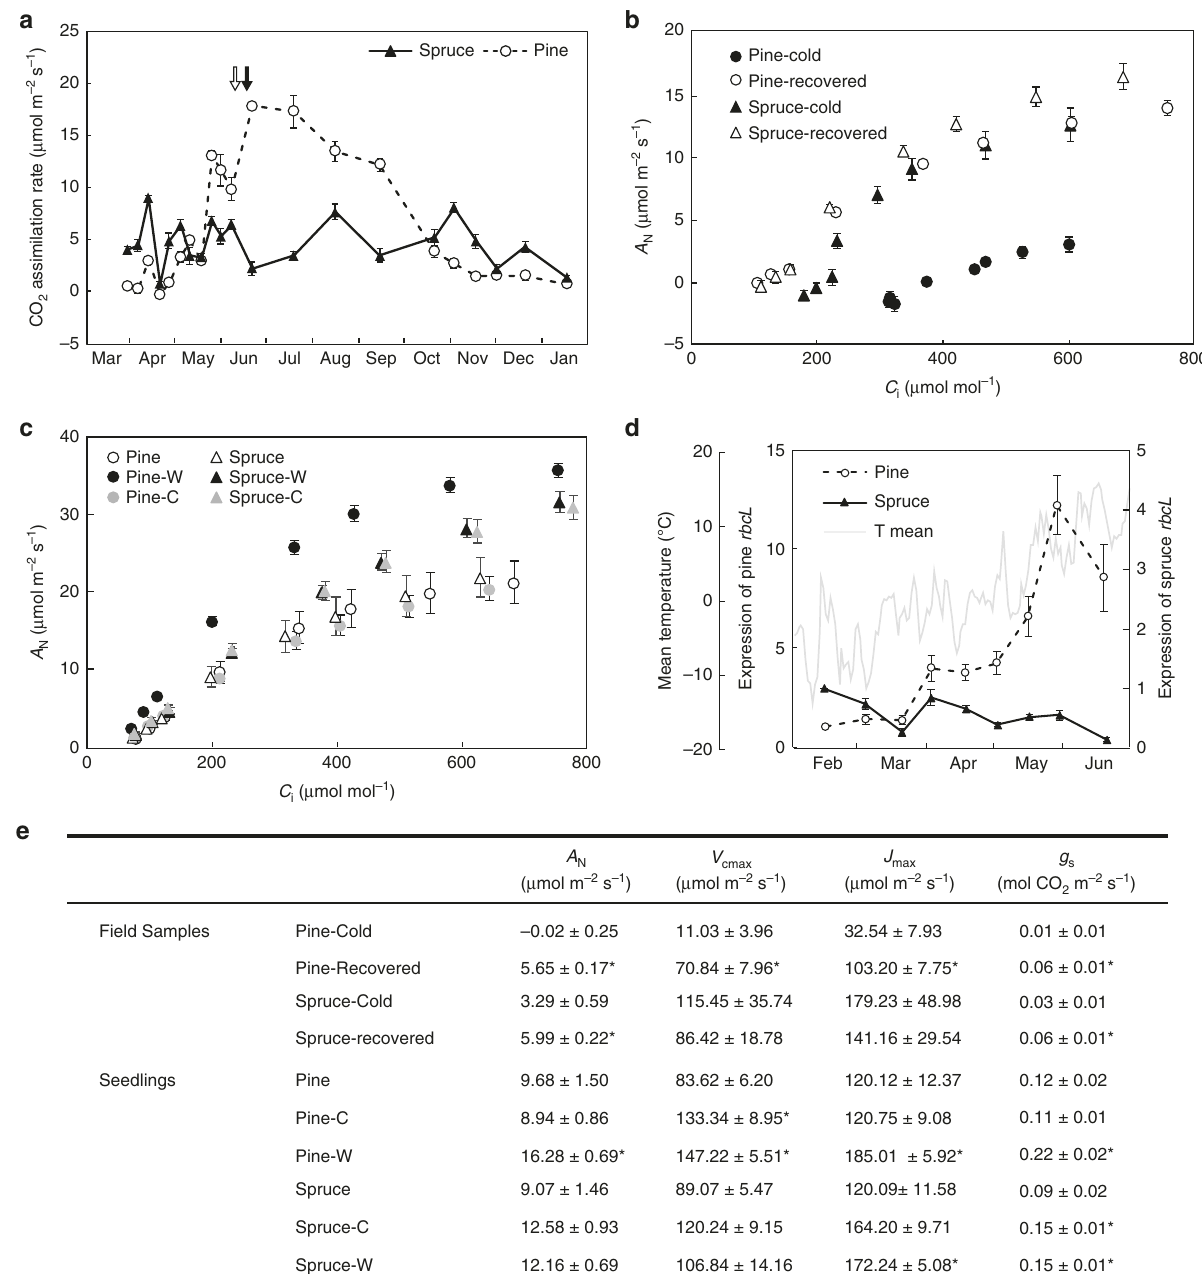
Fig. 3 The capacity for CO 2 assimilation is downregulated in winter and reactivated with warm temperature in Scots pine. a Seasonal photosynthetic CO 2 assimilation ( A N ) was measured under saturated conditions (light intensity, 1200 μ mol photons m − 2 s − 1 and CO 2 concentration, 800 μ mol mol − 1 , 23 °C). Needles of Scots pine (open circle) and Norway spruce (closed triangle) were collected from March 2017 through January 2018. The dates of budburst in Scots Pine and Norway spruce are indicated with open and closed arrows, respectively. b Response of assimilation ( A N ) to the internal CO 2 concentration ( C i ) in a controlled recovery experiment. Samples of Scots pine (closed circle) and Norway spruce (closed triangle) were collected from the fi eld in April. After the initial measurements, the Scots pine (open circle) and Norway spruce (open triangle) samples were recovered in room temperature for 24 h, and measured again. c Response of assimilation ( A N ) to the internal CO 2 concentration ( C i ) in seedlings grown in climate chambers. The A / C i curves were measured in 1-year-old cold-acclimated Scots pine (open circle) and Norway spruce (open triangle) seedlings. Seedlings were transferred either to warm (22 °C, indicated in black) or cold (5 °C, indicated in gray) chambers for 4 weeks, and A / C i curves were determined again. d rbcL expression during the spring recovery phase in Scots pine (open circle) and Norway spruce (closed triangle). Relative expression values were normalized against the reference gene PP2A and related to the amount present in the February samples. Each data point represents the mean (± SE) of at least three replicates. The daily mean of air temperature (gray line) for the period February to May 2017 is shown in light gray. e Photosynthetic parameters calculated from the A / C i curve are shown in b and c . A N rate of CO 2 assimilation, V cmax maximum rate of carboxylation, J max maximum rate of electron transport, g s stomatal conductance. Units are μ mol m − 2 s − 1 . Asterisks indicate the signi fi cant difference between values calculated from treatments and control (one-way ANOVA, P < 0.01). Each data represent mean of 4 – 6 replicates (mean ± SE, n = 4 –